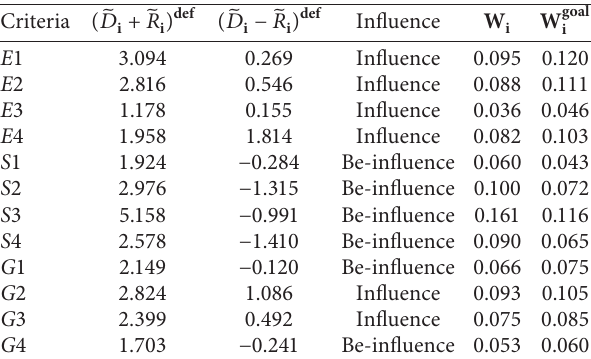
Table 30: Importance weight of sustainability criteria in de- terministic condition.